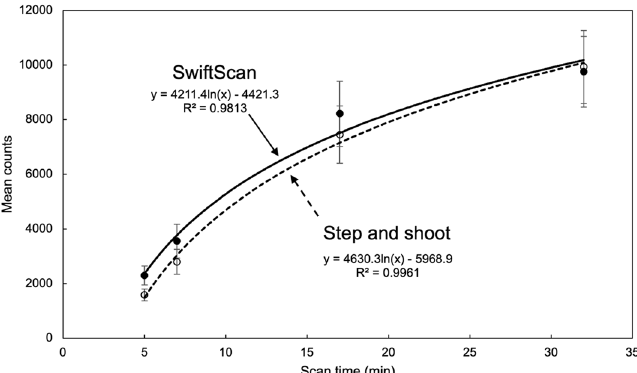
Fig. 7 Relationships between scan time and mean counts. The solid line indicates SwiftScan SPECT and the dashed line indicates step and shoot mode (SSM). Error bar shows standard